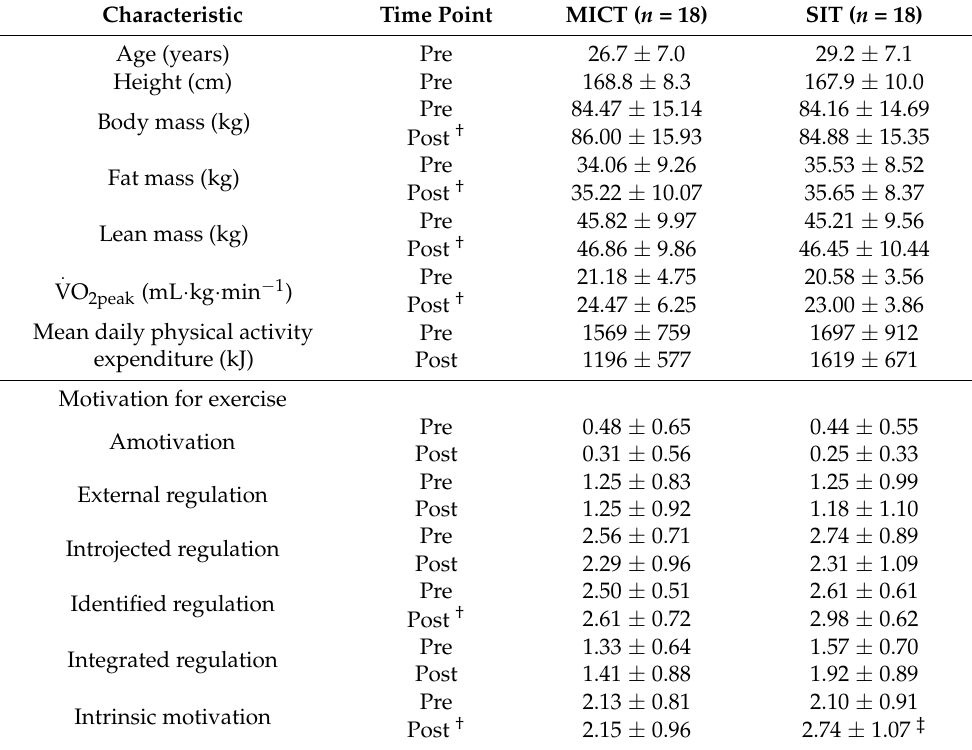
Table 2. Descriptive characteristics of participants pre- and post- 12 weeks of SIT or MICT (mean ±